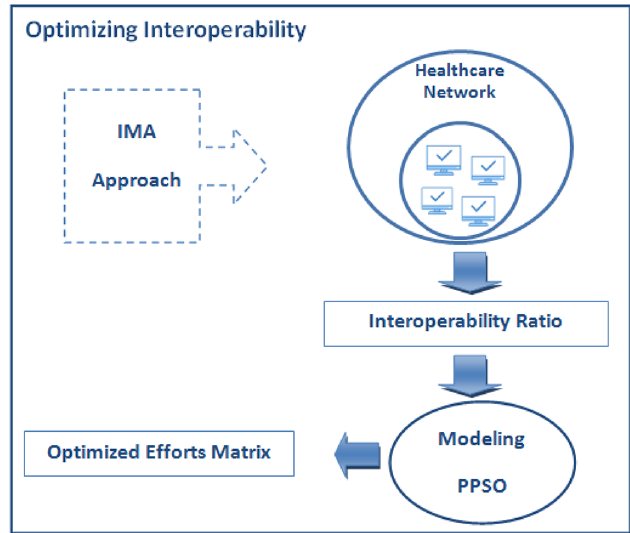
Fig. 9. Interoperability optimization